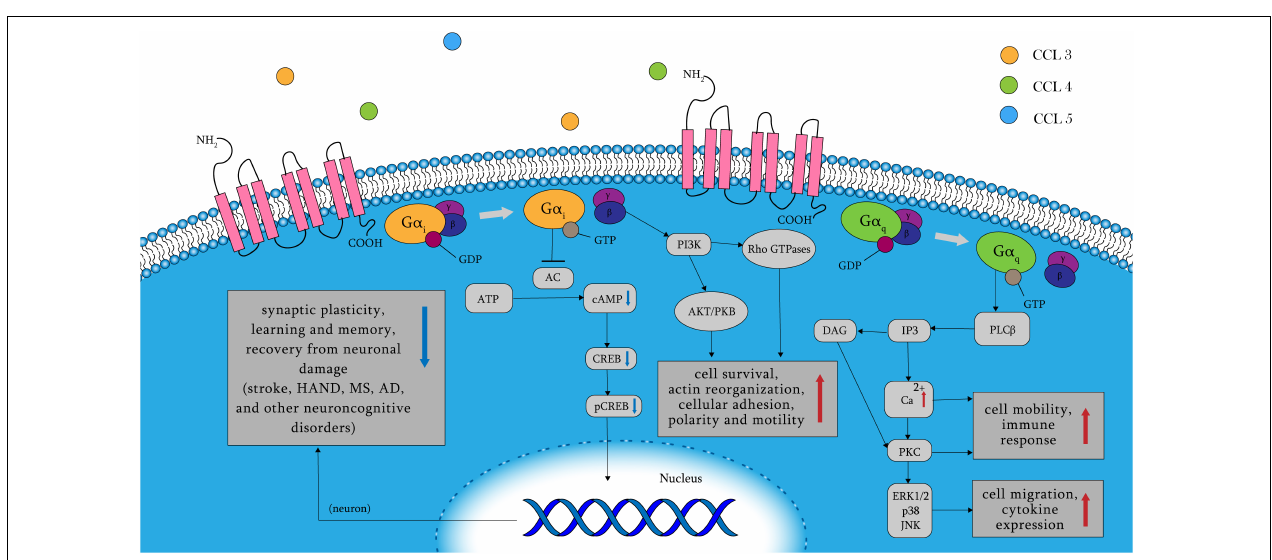
FIGURE 1 | CCR5 receptor signaling pathways. When the amino terminus of CCR5 binds to its ligand, its following signaling pathway is mainly controlled by G α q , G α i , and βγ subunits. The G α i pathway results in the release of intracellular Ca 2 + and decreased learning and memory function, as well as worsened recovery from neuronal damage by reduced cAMP and pCREB. Activation of G α q results in cell migration and cytokine expression in immune response. And the βγ subunits leads to cell survival, adhesion and motility through multiple following signaling pathways such as AKT/PKB and Rho GTPase. AC, adenylyl cyclase; AD, Alzheimer’s disease; AKT/PKB, protein kinase B; cAMP, cyclic adenosine monophosphate; CCR5, C–C chemokine receptor 5; CREB, cAMP-response-element binding protein; DAG, diacylglycerol; HAND, HIV-related neurocognitive disorders; IP3, inositol 1,4,5-trisphosphate; JNK, C-Jun N-terminal kinases; MS, multiple sclerosis; pCREB, phosphorylated cAMP-response-element binding protein; PKB/Akt, protein kinase B; PKC, protein kinase C; PLC, phospholipase C.